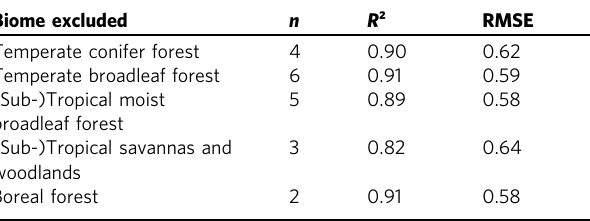
Table 2 Coef fi cient of determination ( R ²) and root mean square error (RMSE) after excluding individual biomes from the ´best´ linear regression